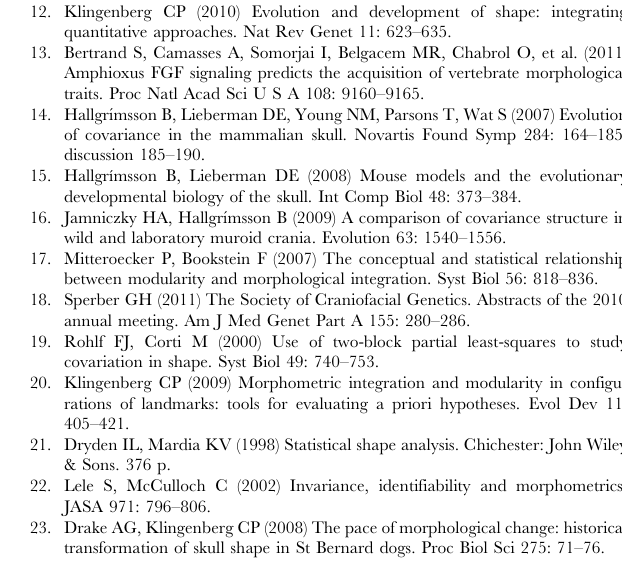
Table S1 Anatomical definitions of 16 three-dimensional skull landmarks collected from m CT images of mice at P0. Landmarks are illustrated in Fig. 1. Supporting Information S1 Modularity test: facial and neurocranial skeleton within the skull of Fgfr2 + /S252W and Fgfr2 + / P253R Apert syndrome mouse models and their non-mutant littermates. Supporting Information S2 Morphological integration pat- terns between 1) neural crest/mesoderm derived bones and 2) endochondral/intramembranous